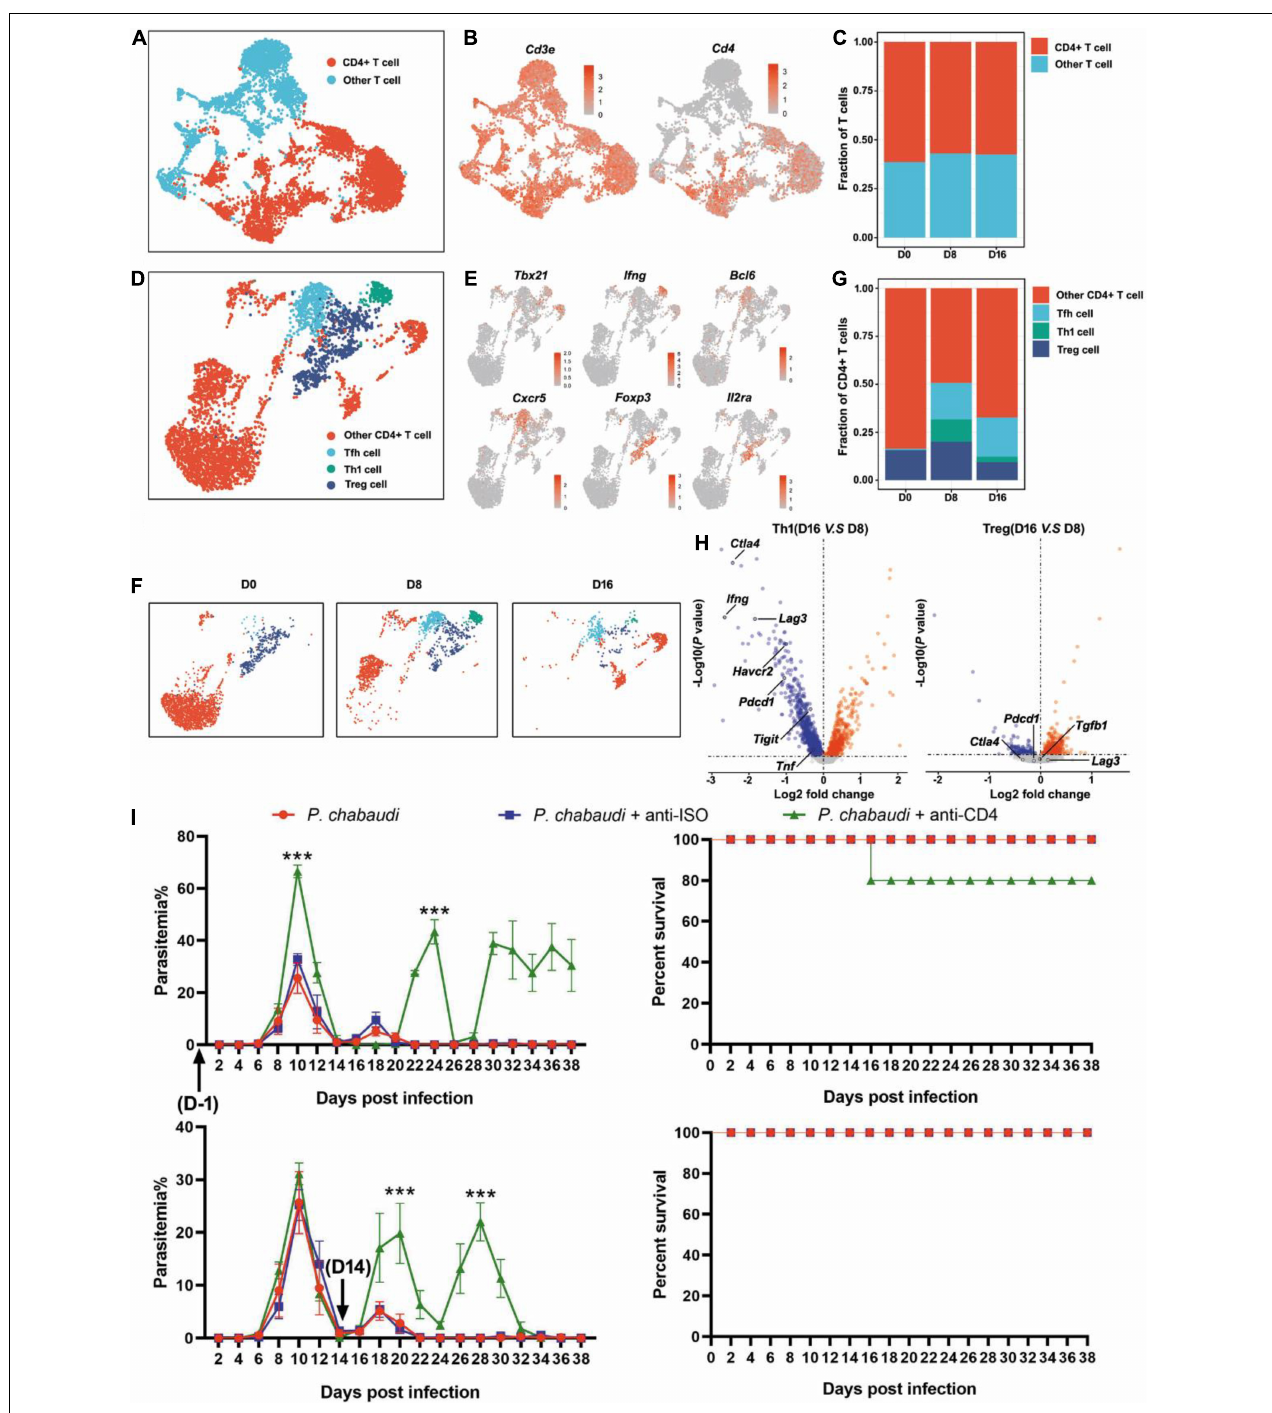
FIGURE 2 | The functions of CD4 + T cells during the acute and recurrence stages of P. chabaudi infection. (A) UMAP projection plot of T cell populations merged from the three time points. (B) Feature plots depicting single-cell expression of canonical immune cell markers of CD4 + T cells. (C) Cell abundance frequencies relative to the total number of T cells at each time point. (D) UMAP plot of CD4 + T cells pooled together from the three time course samples. (E) Marker gene expression in CD4 + T cell clusters. (F) UMAP plot of CD4 + T cells (as in D ) split into the three stages of infection. (G) Fraction of cells in each population relative to the total number of CD4 + T cells at each time point. (H) Volcano plots showing differential gene expression profiles between clusters of Th1 and Tfh cells at different time points, with a P -value of < 0.05. Blue represents downregulated genes and red represents upregulated genes. (I) Wild type (WT) mice ( n = 5) were injected with anti-CD4 or control IgG on days –1, 1, 3, 5, 7 or days 14, 16, 18, 20, 22 after the challenge. All the mice were challenged with P. chabaudi on day 0, and the parasitemia and survival rate were monitored. All experiments were performed in triplicates and the data are presented as means ± SD, *** P <